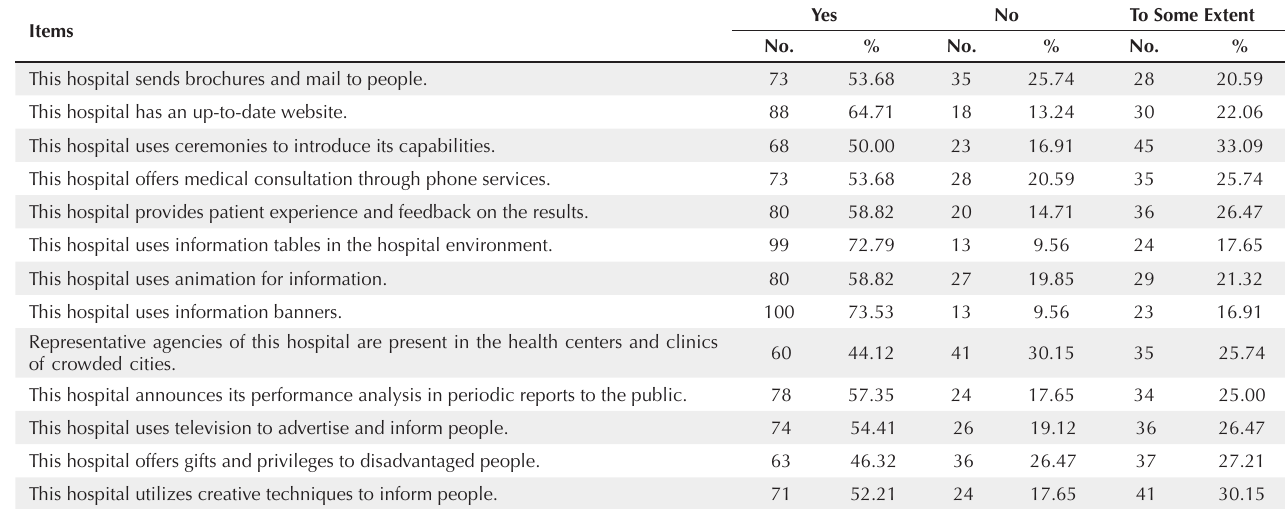
Table 3. Percentage of Responses to Items Related to